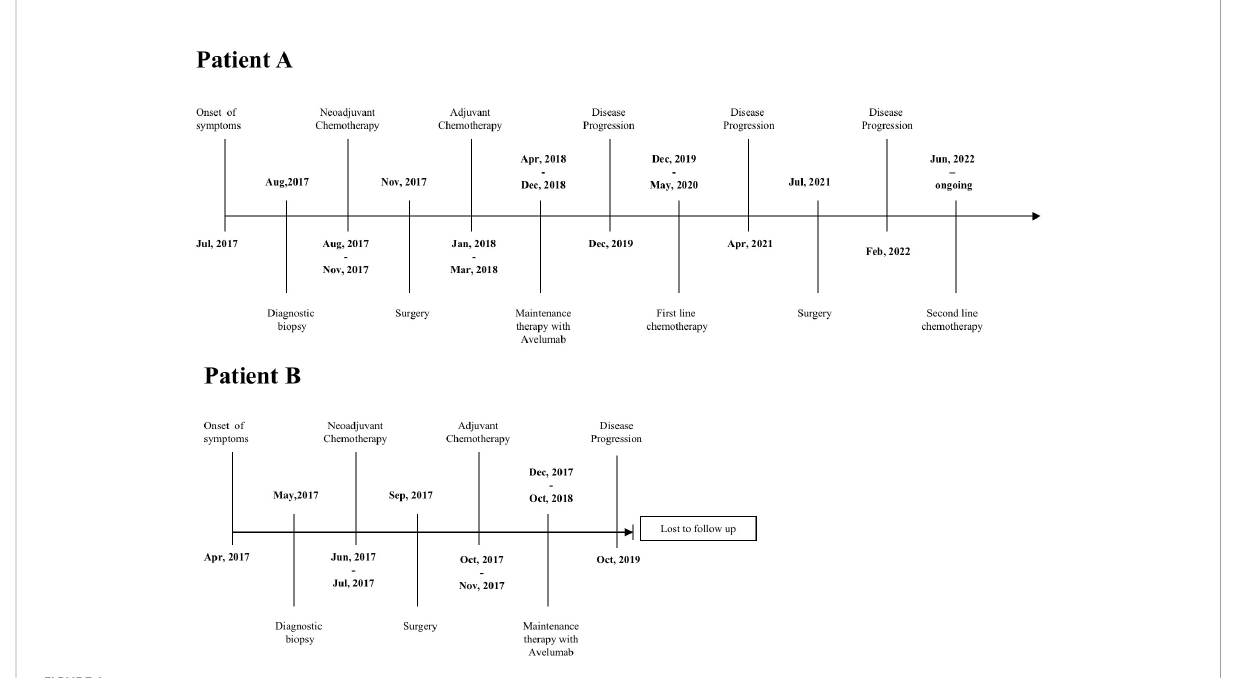
FIGURE 1 Visual snapshot of signi fi cant healthcare events of Patients A and